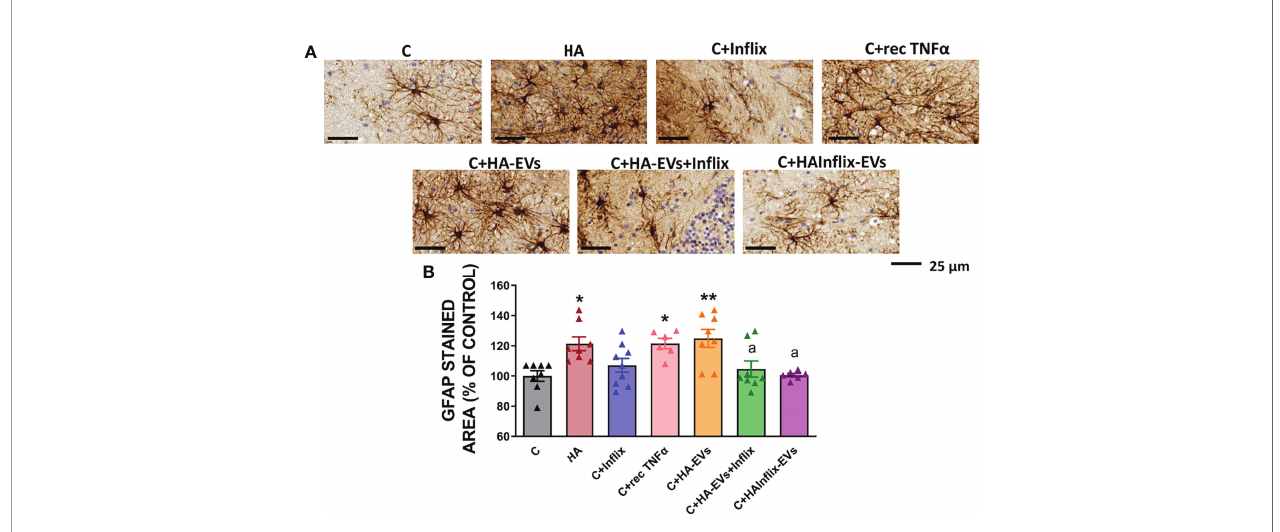
FIGURE 2 | Astrocytes activation after ex vivo incubation of cerebellar slices from control rats with extracellular vesicles from hyperammonemic rats. (A) Representative images of the immunohistochemistry against GFAP in cerebellar slices (white matter) after the ex vivo incubation. (B) Area stained with GFAP expressed as percentage of controls (n=6-9). Sample size indicates number of animals. One-way ANOVA with Tukey post-hoc test was performed to compare all groups. Values are the mean±SEM. Values signi fi cantly different from controls are indicated by asterisk (*p<0.05, **p<0.01) and values signi fi cantly different from C +HA-EVs group are indicated by a (a = p<0.05). Scale bar = 25